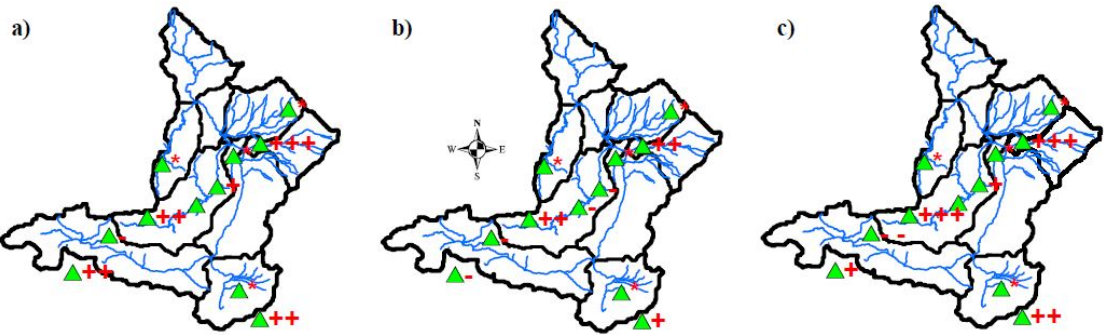
Figure 2. Spatial variation of temperature trends showing Z values in the Mann-Kendall test during the dry season: ( a ) minimum, ( b ) maximum, and ( c ) mean temperature.